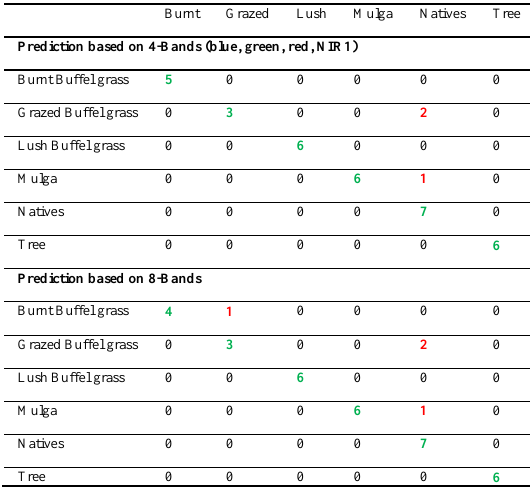
Lush Buffel grass